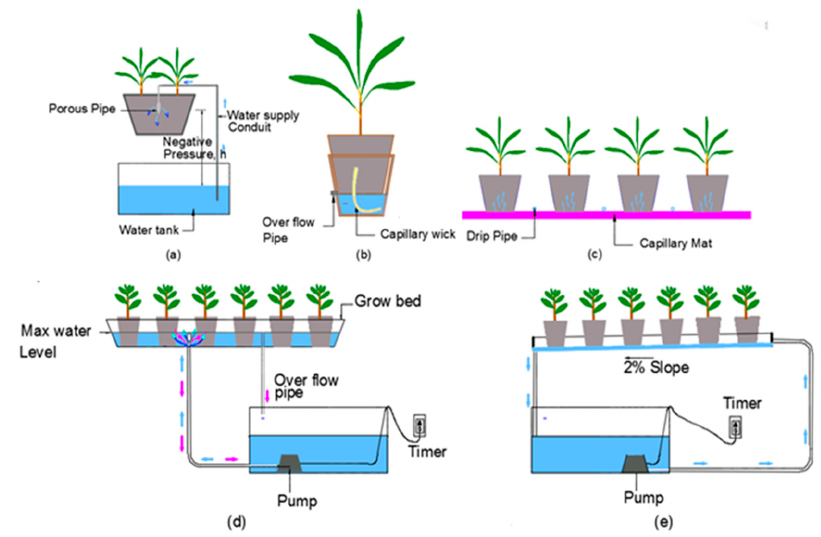
Figure 4. Capillary irrigation systems: ( a ) negative pressure difference irrigation (NPDI), ( b ) capillary wick, ( c ) capillary mat, ( d ) ebb and flow—flood benches, ( e ) ebb and flow—trough.